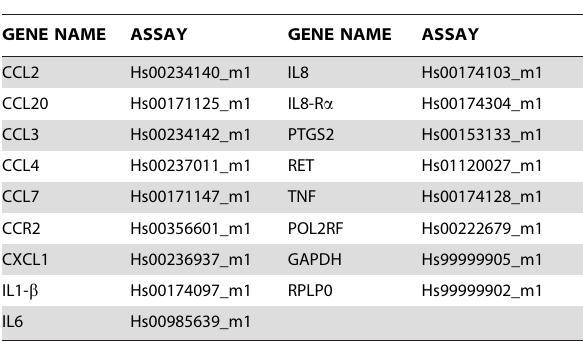
Table 2. Assays for the real time Figure S1 Confocal microscopy of RET receptor ex- pressed on primary immune cells. Representative examples from an healthy donor of fluorescent confocal microscopic images showing the expression of RET receptor on total PBMCs (panel A with RET labeled in green and cell nucleus in blue), NK cells (panel B with RET labeled in red, CD56 labeled in green and cell nucleus in blue), B cells (panel C with RET labeled in red, CD19 labeled in green and cell nucleus in blue), T cells (panel D with RET labeled in green, CD3 labeled in red and cell nucleus in blue). The co-localization of RET with the different markers of immune cells is labeled in yellow.